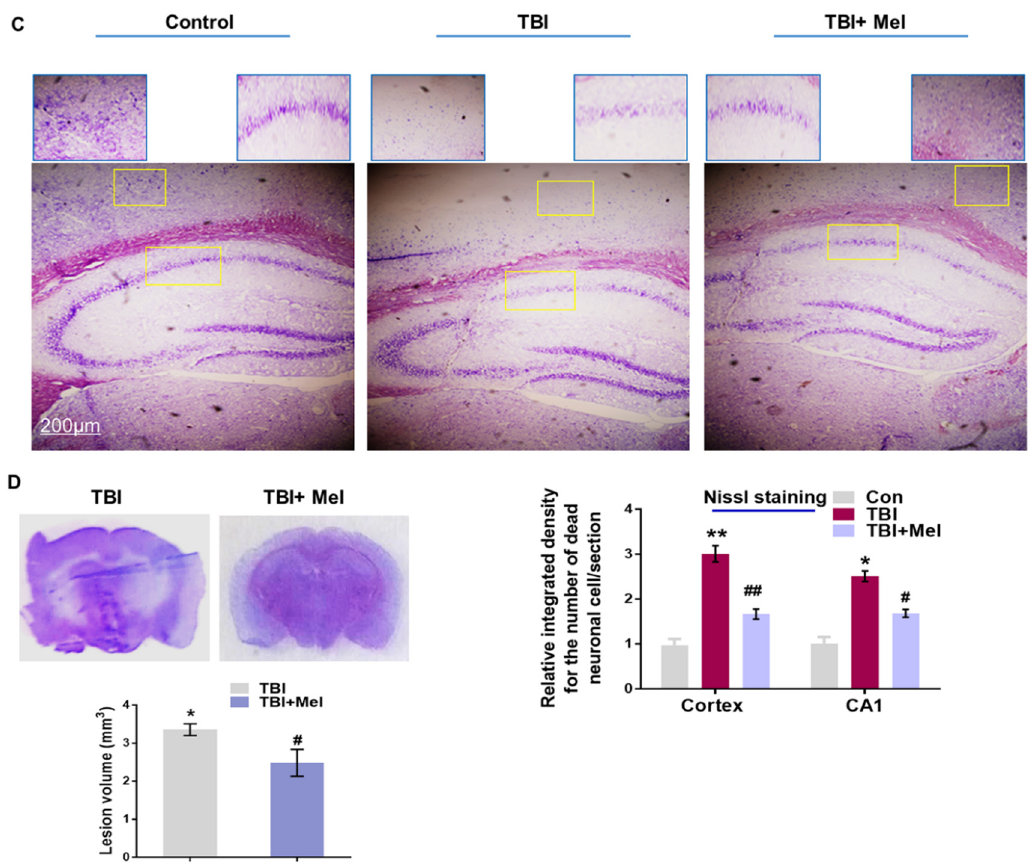
Figure 5. Melatonin rescues the mice brain against the apoptotic cell death associated with repetitive mild traumatic brain injury (rmTBI). ( A ) Western blot analysis and histograms showing the mitochondrial apoptotic signaling markers such as Bax, Caspase ‐ 3, PARP ‐ 1, and Bcl ‐ 2 among the treated mice groups. n = 10 mice per group. Each membrane of the respective band was probed with β‐ actin. β‐ Actin was used as a loading control. ( B ) Confocal microscopy images represent the immunoreactivity of caspase ‐ 3 in the cortex and hippocampal CA1 region of rmTBI and rmTBI plus melatonin ‐ treated mice group. n = 5 mice per group. ( C ) Representative photomicrograph of Nissl staining in the cortices and CA1 regions of the mice brain that received rmTBI and rmTBI plus melatonin treatment. ( D ) Representative images of cresyl violet ‐ stained coronal brain sections from rmTBI and rmTBI plus melatonin ‐ treated group. The images were quantified using ImageJ software. Magnification, 10×. The values are expressed as mean ± SEM. One ‐ way ANOVA followed by post ‐ hoc analysis * p < 0.05 and ** p < 0.01 represent difference between control and rmTBI, and # p < 0.05 and ## p < 0.01 represent difference between rmTBI plus melatonin (Mel) ‐ treated group.